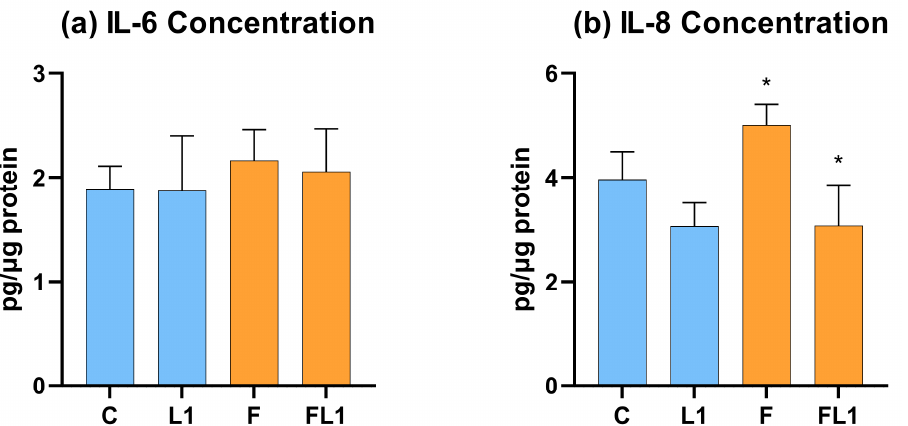
Figure 4. IL-6 ( a ) and IL-8 ( b ) concentration of the cell culture medium measured by chicken-specific ELISA. C = control, L1 = luteolin (4 µ g/mL), F = flagellin (250 ng/mL), FL1 = flagellin (250 ng/mL) ELISA. C = control, L1 = luteolin (4 µg/mL), F = flagellin (250 ng/mL), FL1 = flagellin (250 ng/mL) and luteolin (4 µ g/mL). Mean ( n = 6/group) ± SD, * p < 0.05. Group L1 and F were compared to C, while group FL1 was compared to group